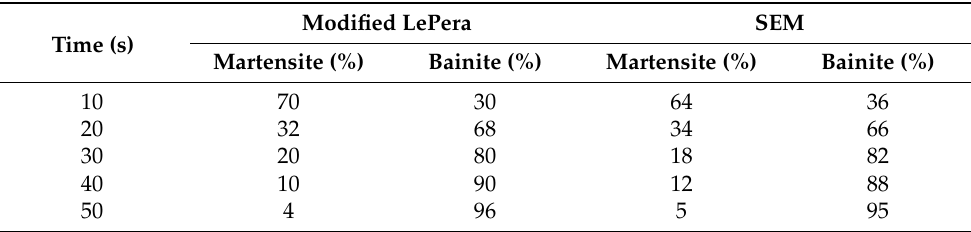
Table 2. The comparison of phase volume fractions of 22MnB5 samples with varying holding time by two-stage color tint-etching approach and SEM.